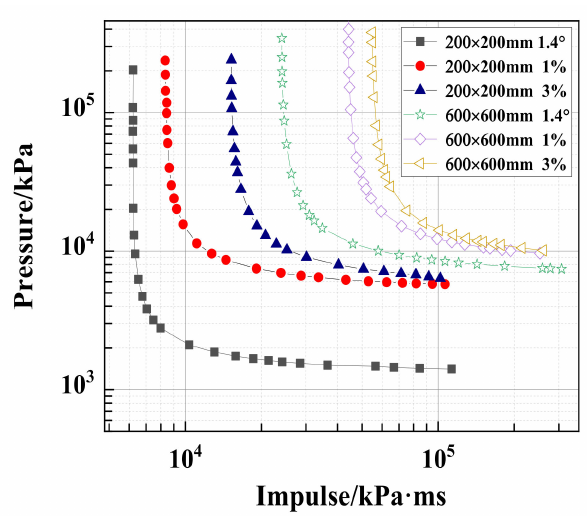
Figure 14. Analysis of P-I curves with cross-sectional dimensions, 200 × 200 mm and 600 × 600 mm.